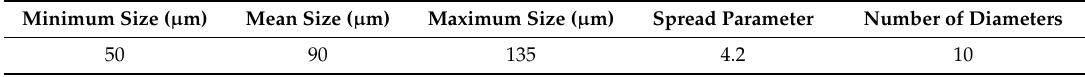
Table 3. Particle size, which follows a Rosin-Rammler